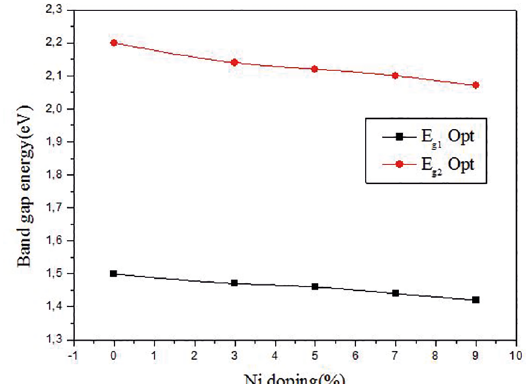
O films at 3 4 different Ni-doping amounts